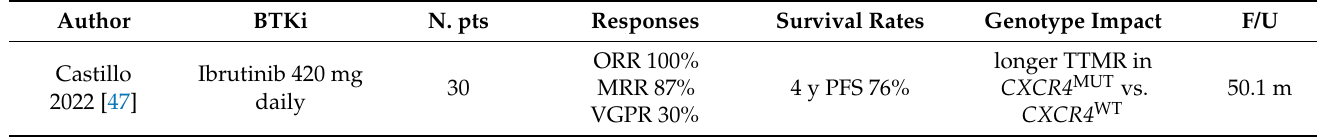
Table 2. Summary of clinical trials data of BTKi in untreated WM